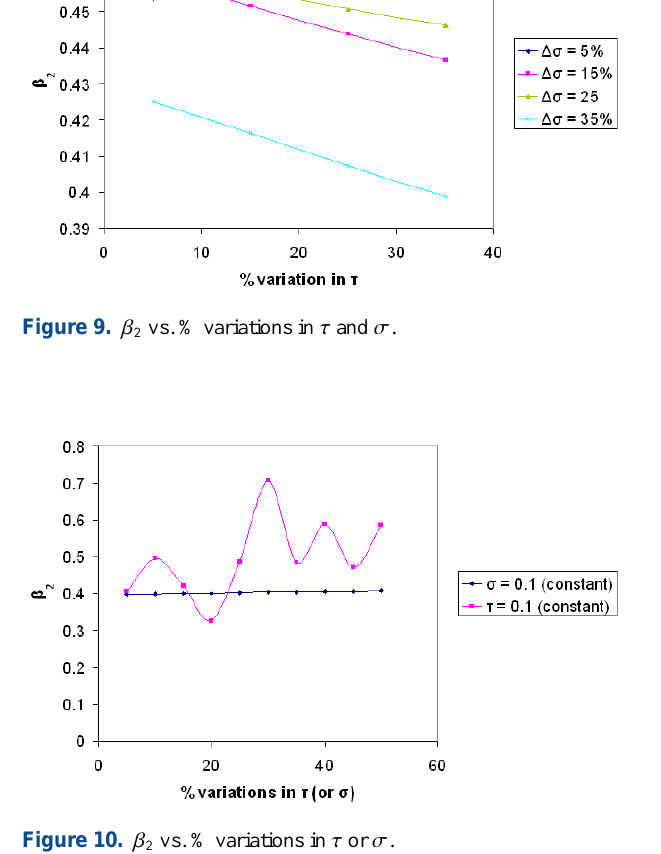
Figure 10. β 2 vs. % variations in τ or σ